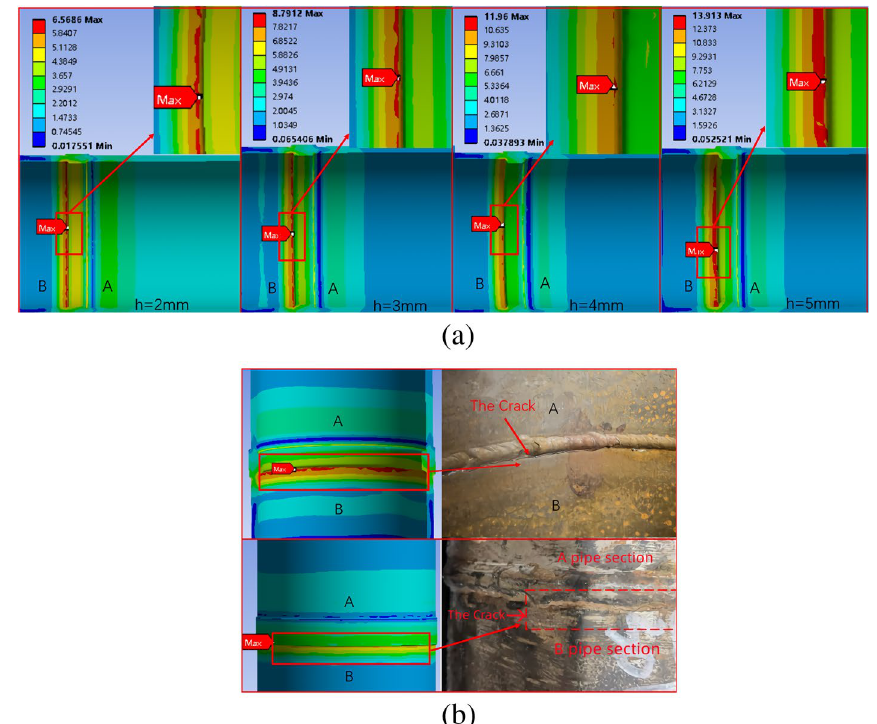
Fig. 33 A Pipe outer surface microstructure